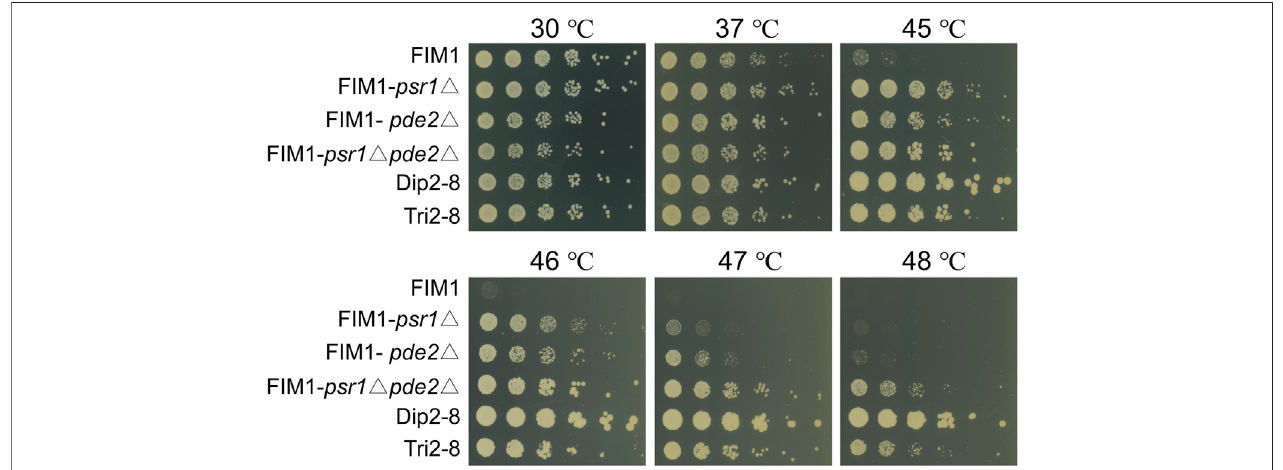
FIGURE 3 | Spot assays of FIM1 carrying the deletion of PSR1 , PDE2 or a combination of both deletions. FIM1, Dip2-8 and Tri2-8 were spotted as